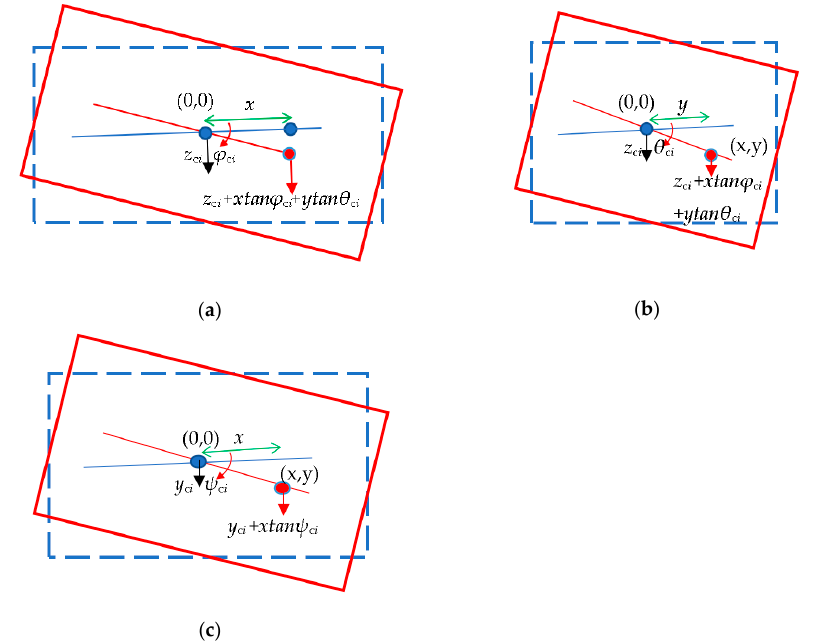
Figure 2. Linear zonal relation model of car-body motion between the center and a certain point. ( a ) front view of car-body motion of the vertical levitation and the pitch; ( b ) lateral view of car-body motion of the vertical levitation and the roll; ( c ) top view of car-body motion of the lateral sway and the yaw. Therefore, the zonal distribution of the vertical acceleration can be derived using Equation (19). In the case of horizontal acceleration, the horizontal coordinate ( x , y ), lateral sway, and yaw acceleration of the car-body center are considered. Thus, the zonal distri- bution of the horizontal acceleration can be expressed as Equation (20).